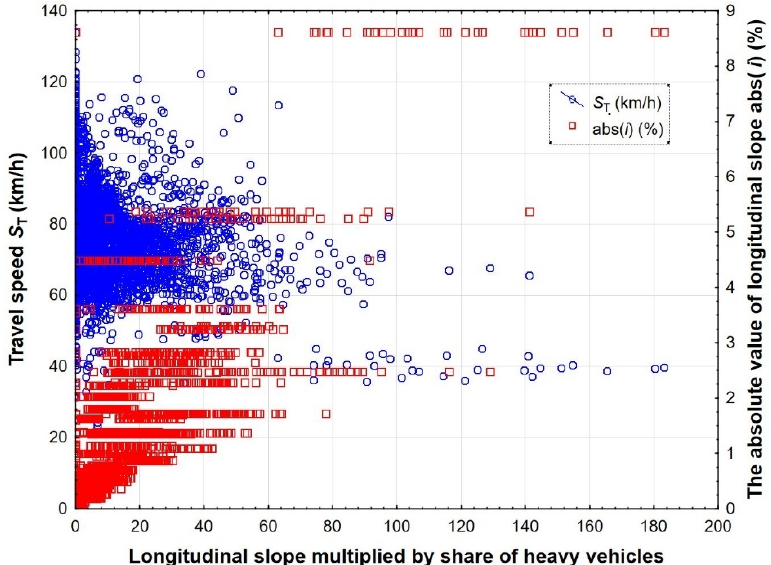
Figure 6. Interaction between travel speed and the combined effect of slope and the share of heavy